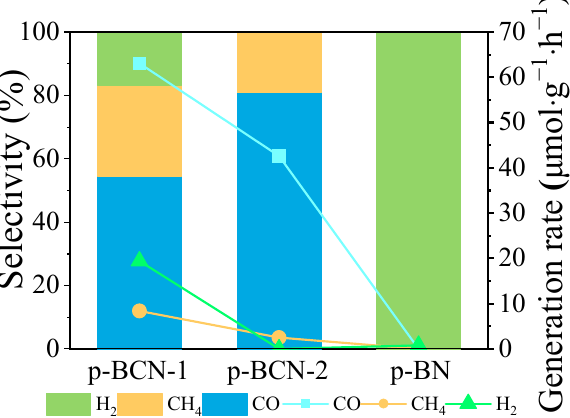
Figure 12. Catalytic performance of p-BN and p-BCN photocatalyzed CO 2 conversion. Table 1. Photocatalytic CO 2 reduction performance of different photocatalysts in the presence of H 2 O.